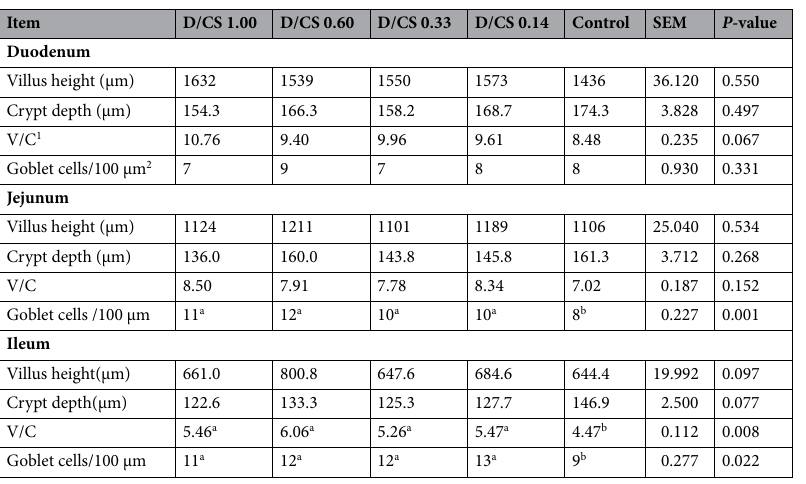
Table 5. The effects of NFD on intestinal morphology of broiler chickens. 1 V/C: The ratio of villus height to crypt depth. 2 The number of goblet cells were quantified by counting the number of stained goblet cells per 100 μm length of villus, and present as the average number of goblet cells per 8 intestinal villi. Values are expressed as the mean and pooled SEM ( n = 6 per group). Different superscript letters in the same row mean significant differences ( P < 0.05).